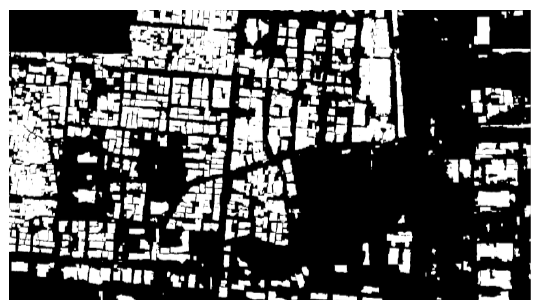
Figure 2 . 2 : Represents noise removal